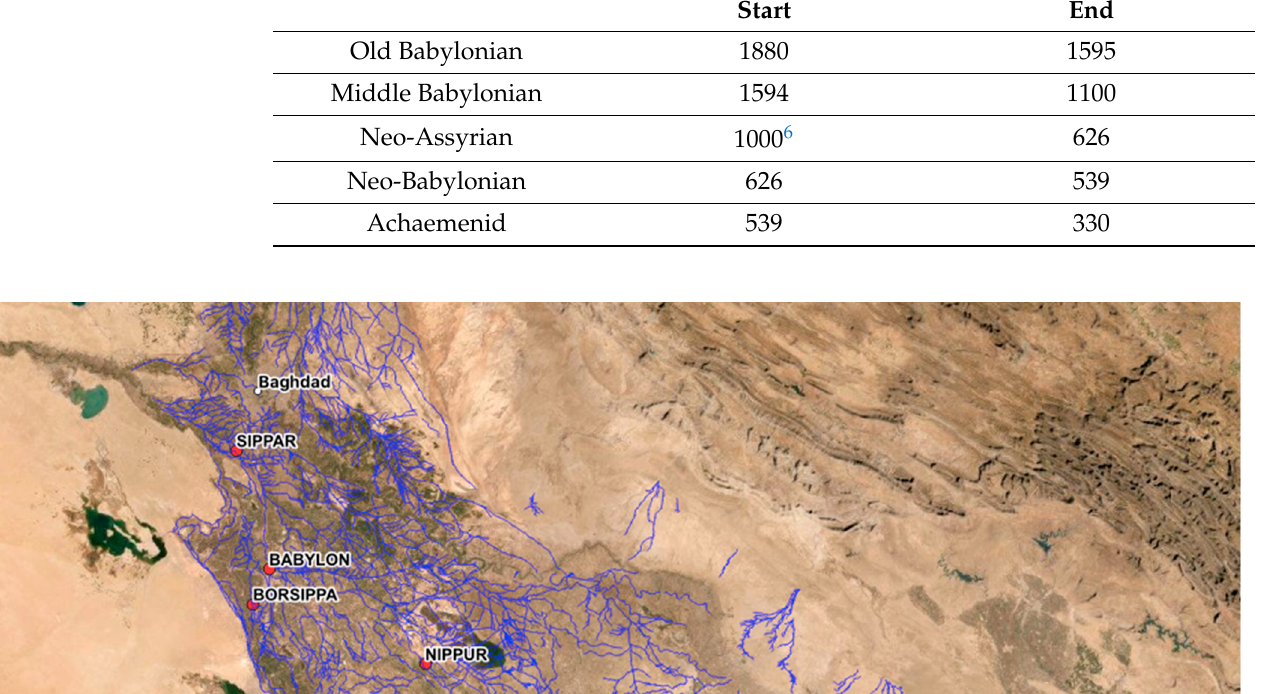
Table 1. Periods of Mesopotamian [25] 5 history [11,26]; all dates are BCE.